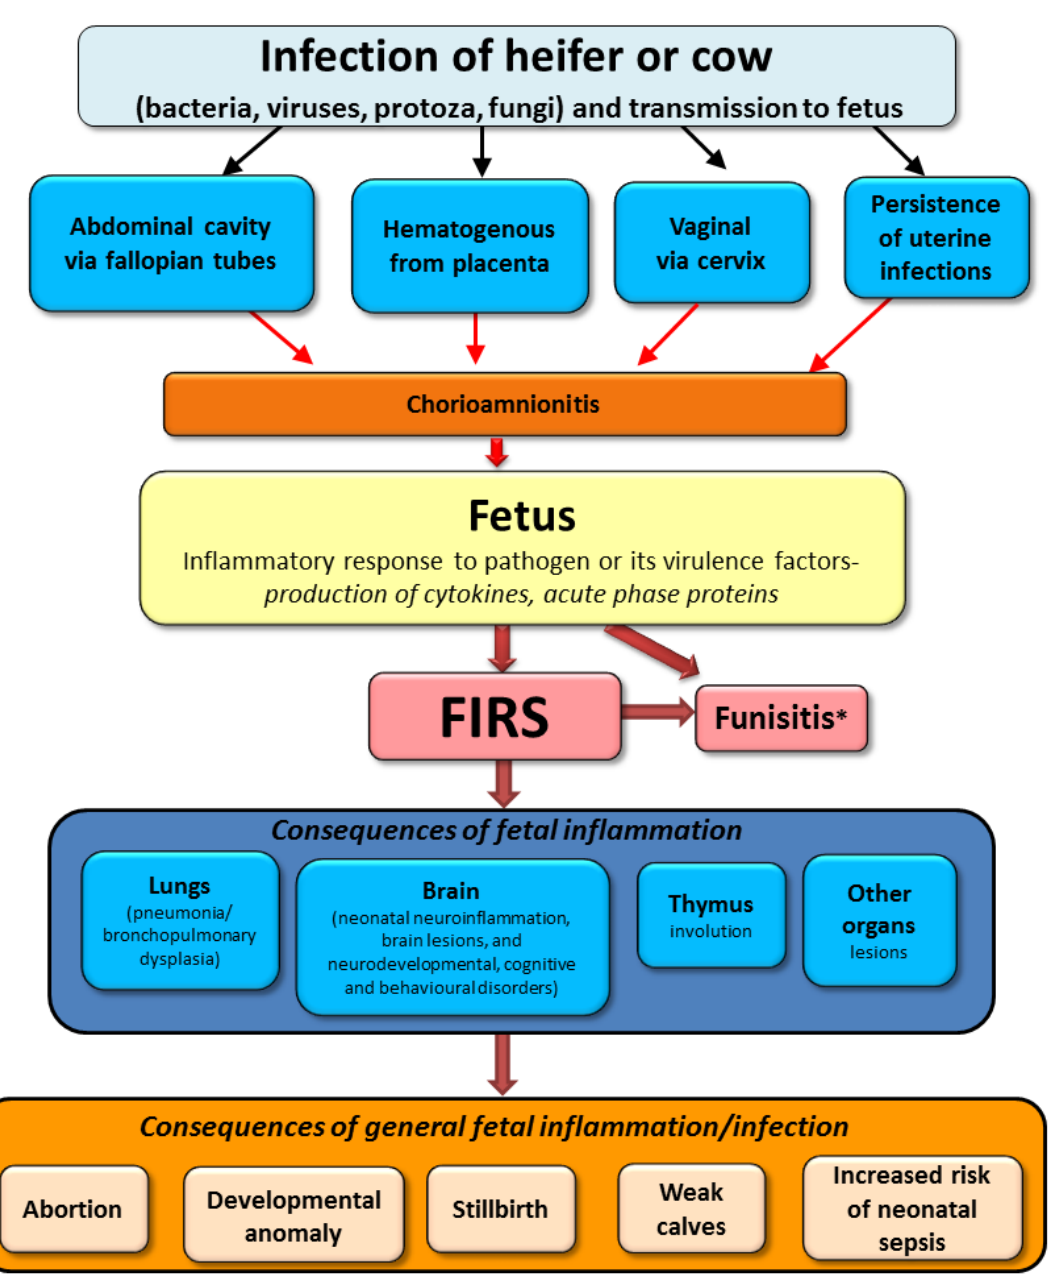
Figure 3. Possible sequelae of intrauterine infection in cattle based on human and animal studies (FIRS; fetal inflammatory response syndrome). * Funisitis-inflammation of umbilical vessels is also a hallmark of human FIRS.